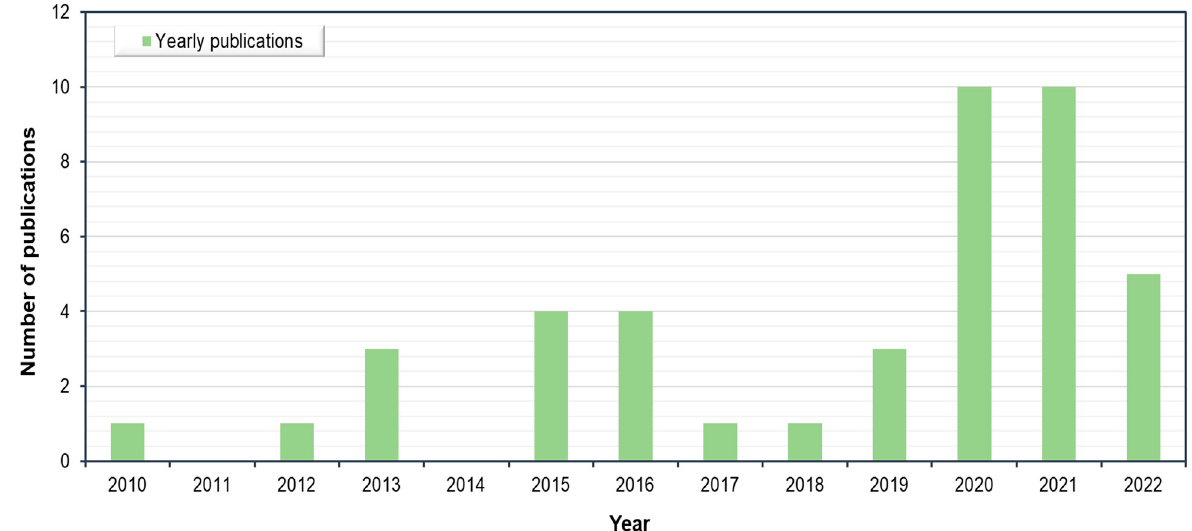
Figure 3. The number of articles for each year.